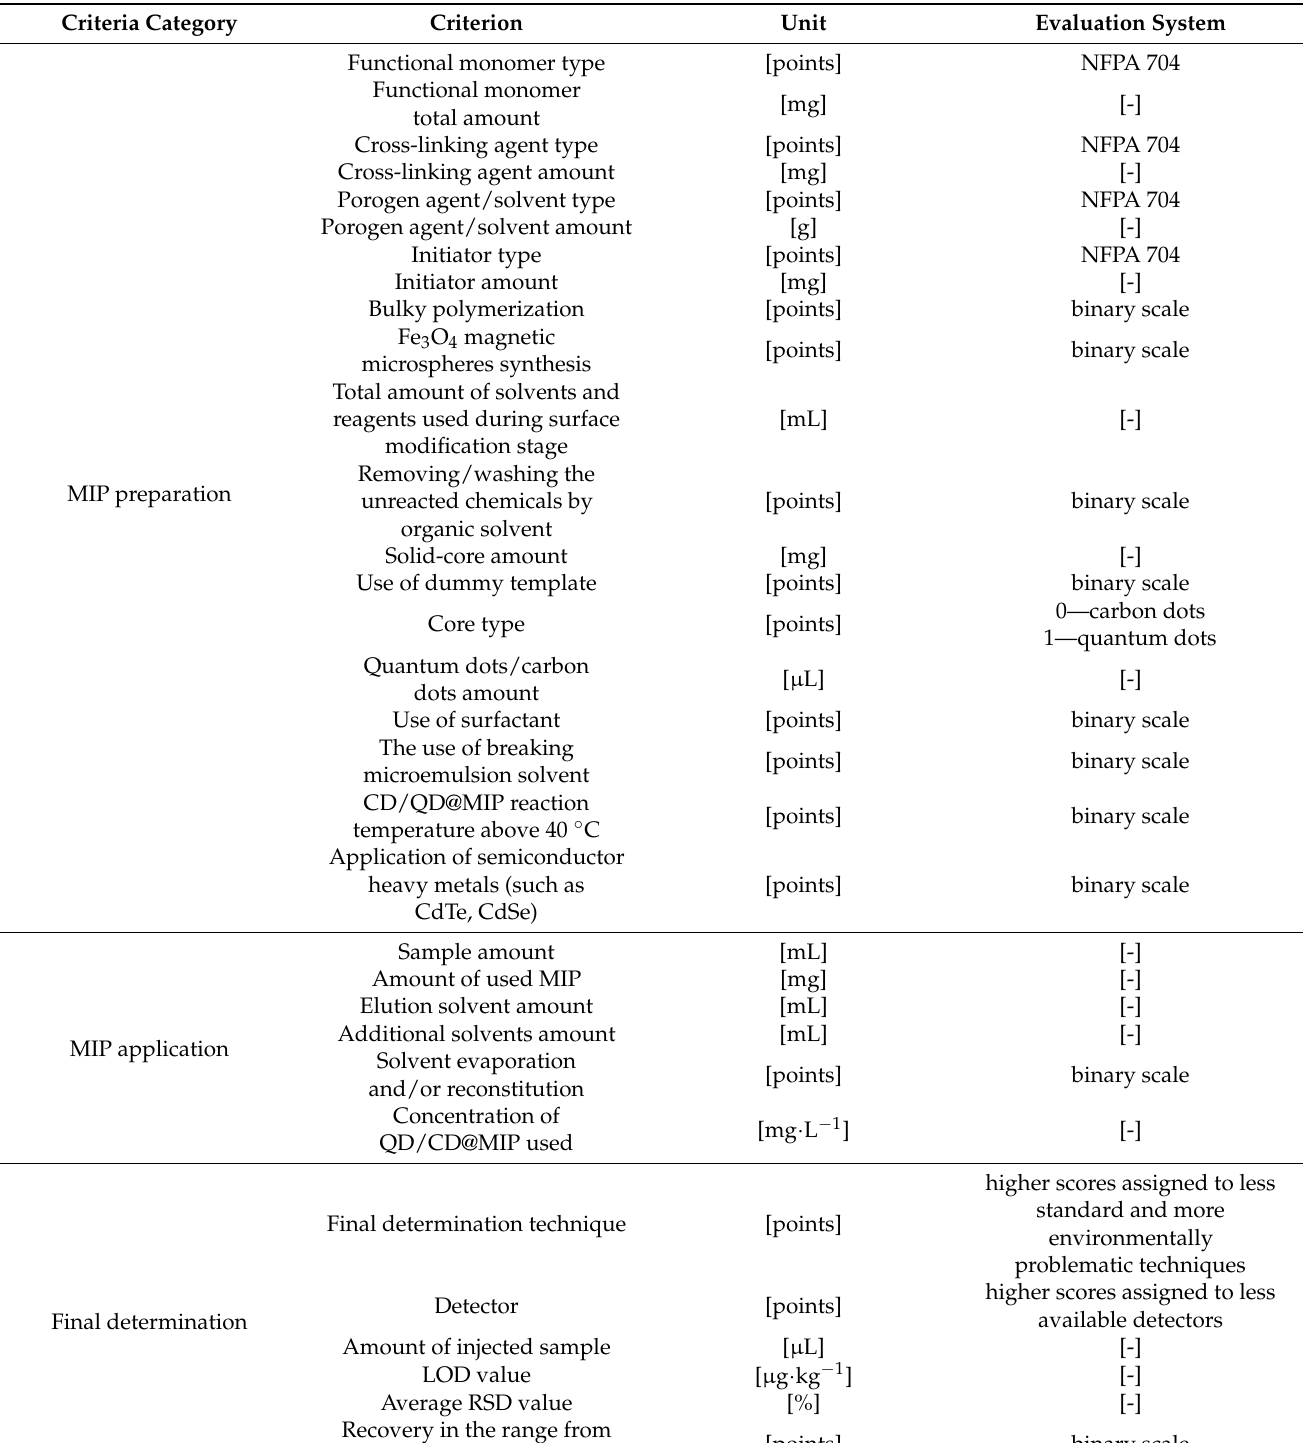
Table 1. Criteria describing for analytical protocols for pesticides determination in environmental and food samples with application of MI-SPE, magnetic MIP and quantum and carbon dots